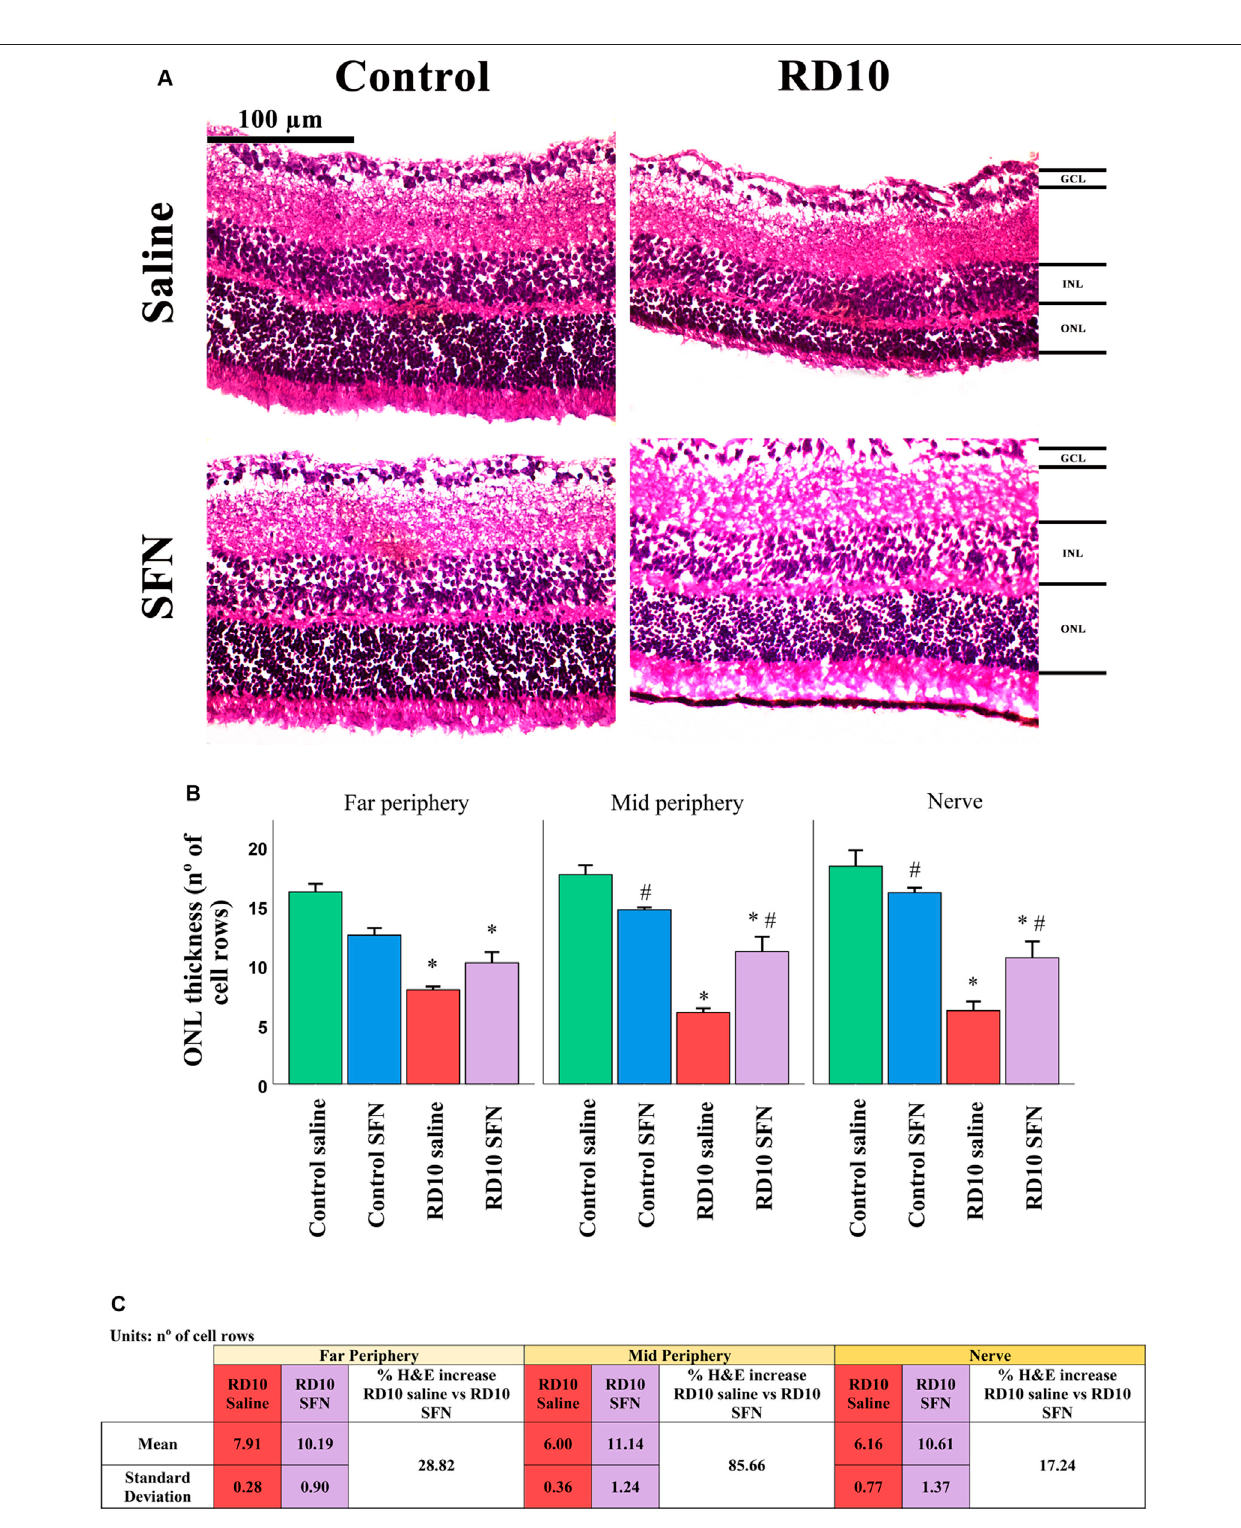
FIGURE2| Hematoxylinand eosin(H&E)cellanalysis. (A) NerveregionH&Eimagesofthedifferentanimalgroupsintheexperiment. (B) Thenumberofcellrowsin the outer nuclear layer (ONL) in the different studied regions. *Differences between Control Saline vs. RD10 Saline or Control SFN vs. RD10 SFN (p-value < 0.05). #Differences betweenControlSalinevs. ControlSFN orRD10Saline vs. RD10SFN( p -value < 0.05). (C) EffectofSFNonRD10 mice H&Ecellcount. RD10experimental groups: mean and standard deviation and H&E cell percentage expression differences.